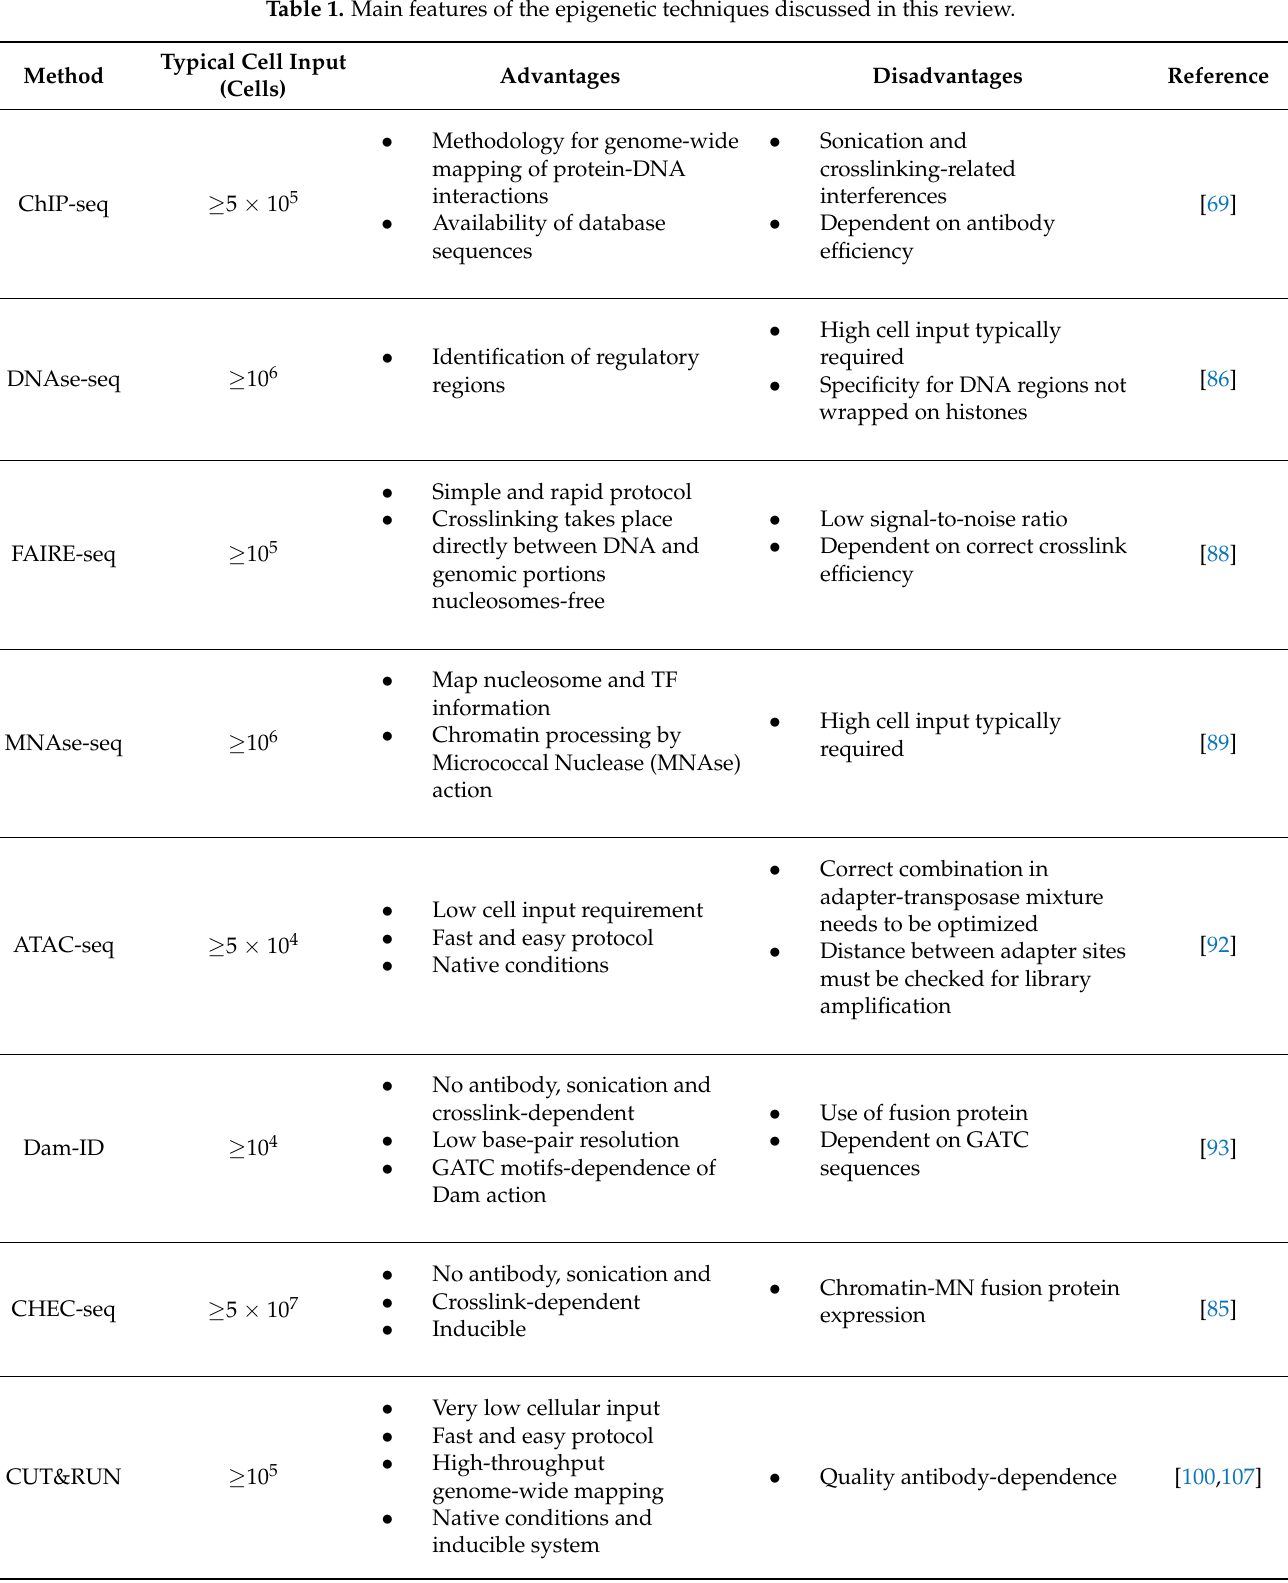
Table 1. Main features of the epigenetic techniques discussed in this